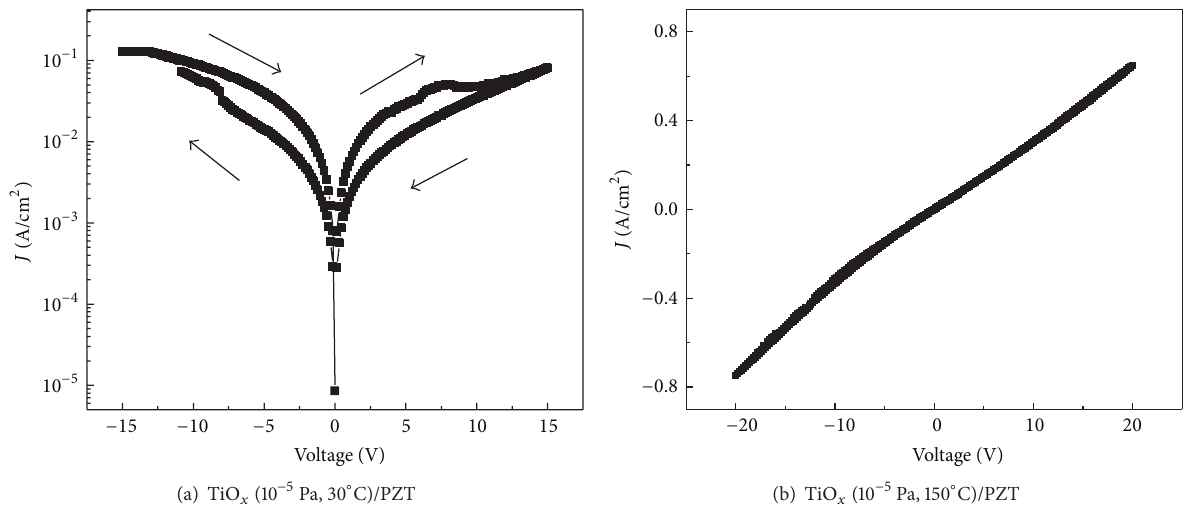
Figure 3: 𝐼 - 𝑉 curves of Pt/TiO 𝑥 /PZT/LSMO in which the TiO 𝑥 layer is deposited at 30 (a) and 150 ∘ C (b) in background vacuum.